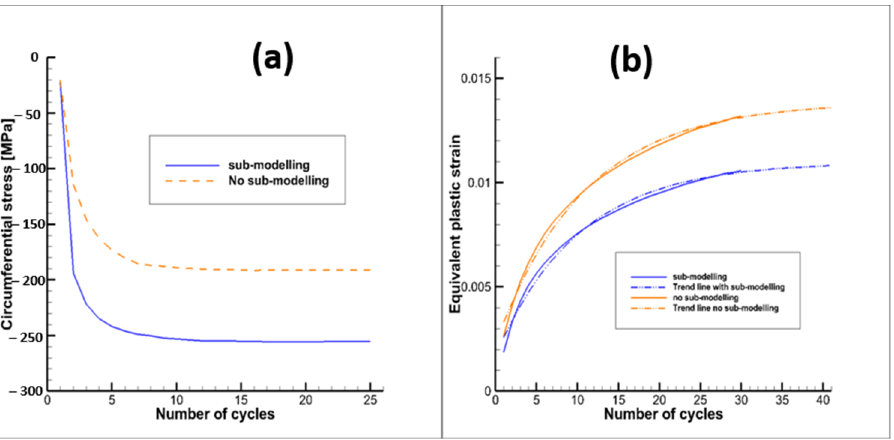
Figure 14. ( a ) Circumferential stress vs time at the end of the hot phase, ( b ) Equivalent plastic strain evolution with number of cycles.